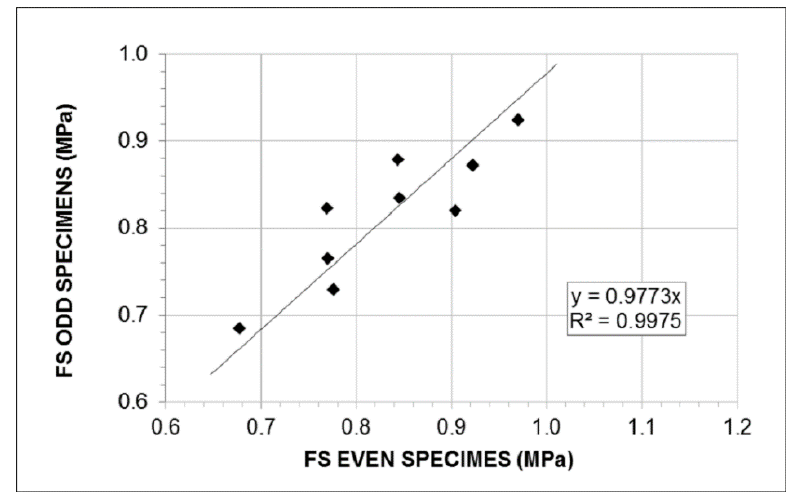
Figure 6. Relationships between flexural strength of samples of the same batch. Table 6. Statistical analysis of the relationship FS odd -FS even .